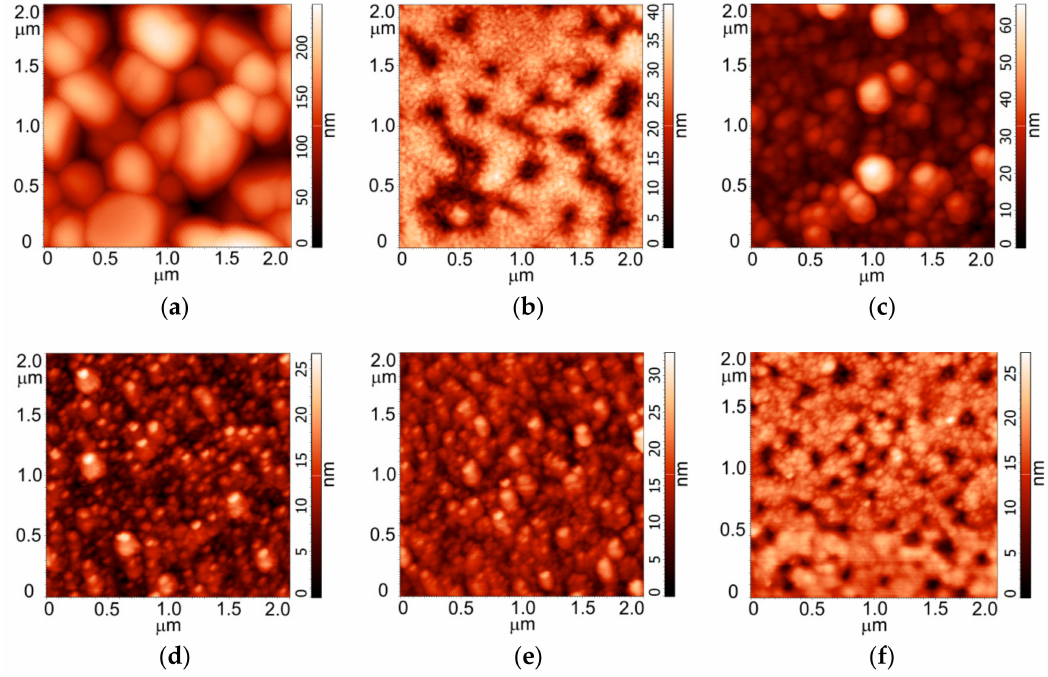
Figure 1. AFM images of the Ca-P coatings on the ZrO 2 substrates: ( a ) ZrO 2 substrate; ( b ) CPT coating; ( c ) HA coating; ( d ) Calcium phosphate monobasic coating; ( e ) DCPD coating; ( f ) CPP